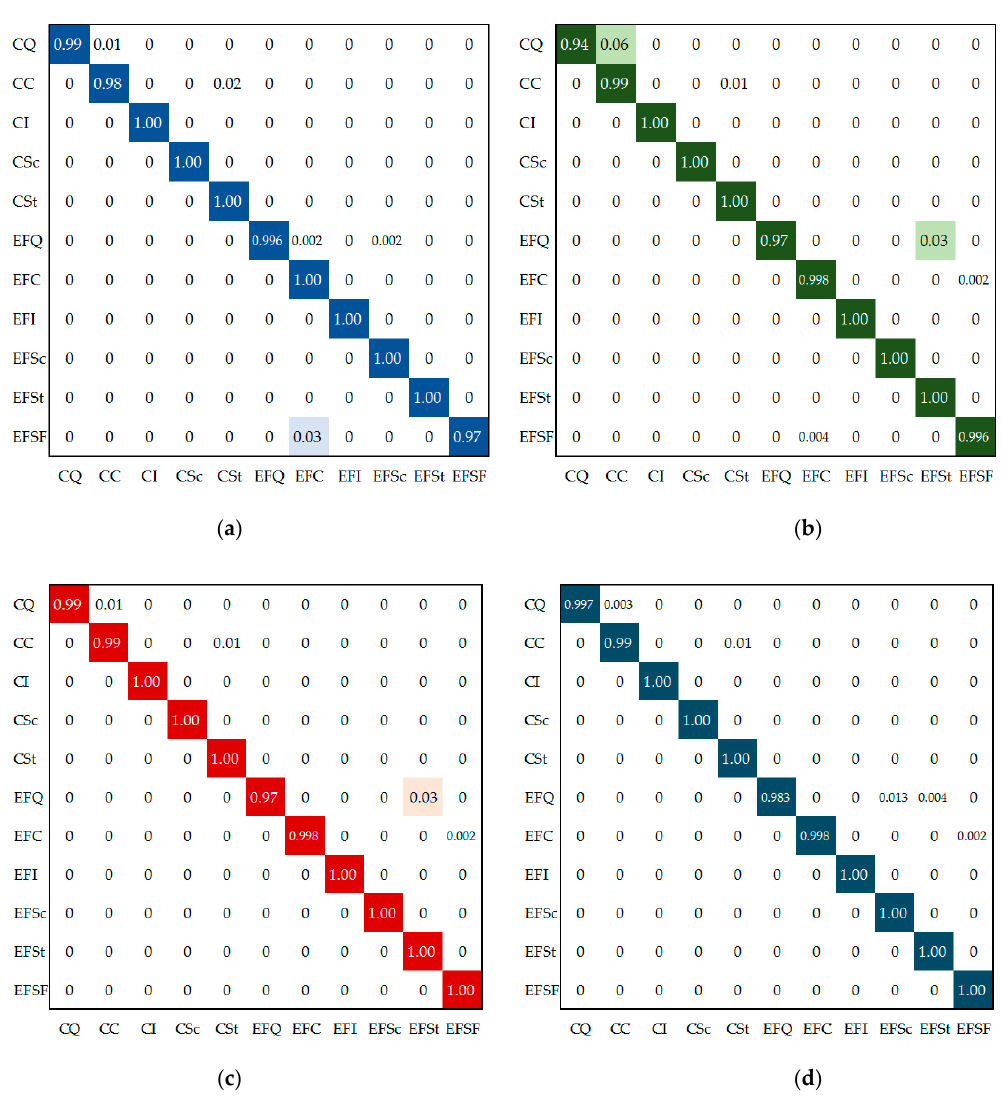
Figure 11. Confusion matrixes for different models: ( a ) deep SDD-Inception v3; ( b ) SDD-SqueezeNet v1.1; ( c ) deep SDD-ResNet18; ( d ) deep SDD-VGG16.